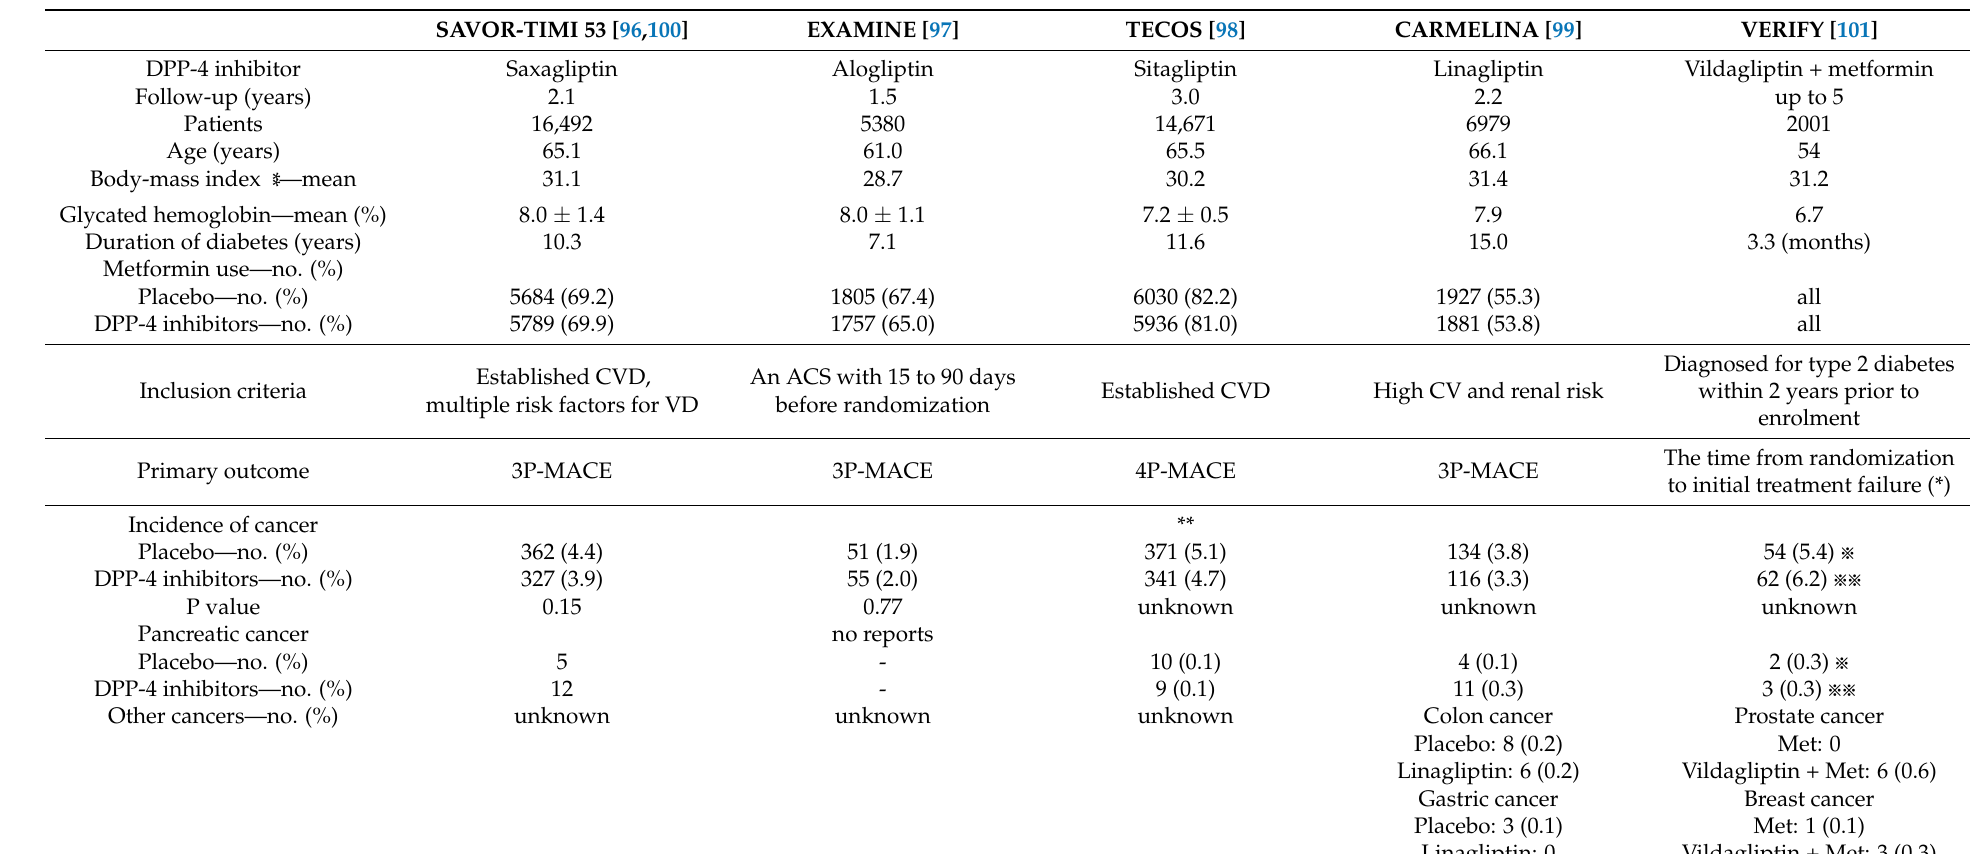
Table 3. Cancer incidence in large clinical trials with DPP-4